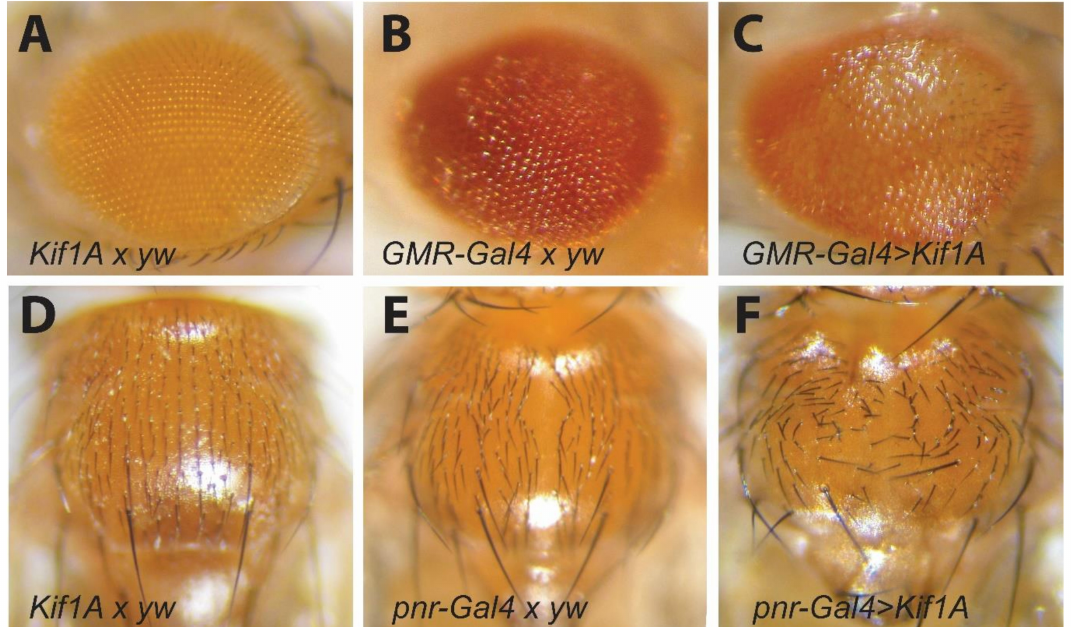
Figure 6. Kif1A overexpression impairs viability and cell polarity: Kif1A overexpression